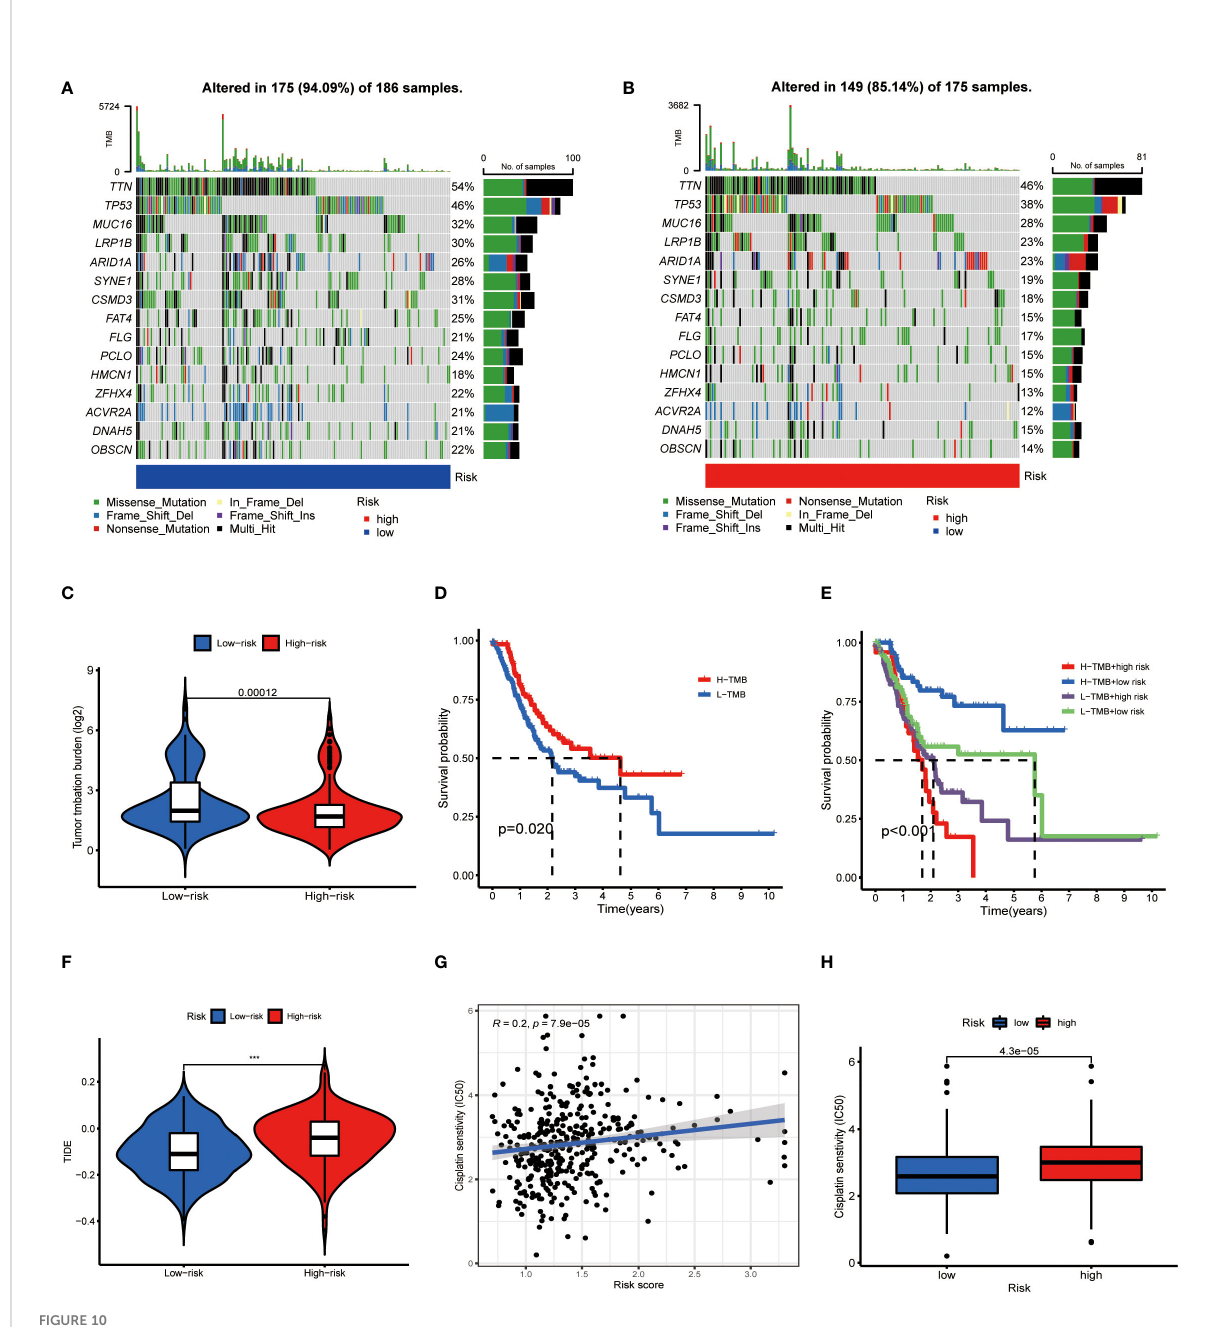
FIGURE 10 Metabolic lncRNAs risk model predicted immunotherapy ef fi cacy. (A, B) Waterfall diagram of high- low-risk GC patients. (C) Tumor mutation burden analysis to compare the TMB of GC patients in two groups. (D,E) Kaplan-Meier analysis to compare the OS of GC patients in different groups. (F) Violin diagram showed the TIDE values of GC patients in two groups. (G,H) Sensitivity of patients with different risk scores to cisplatin